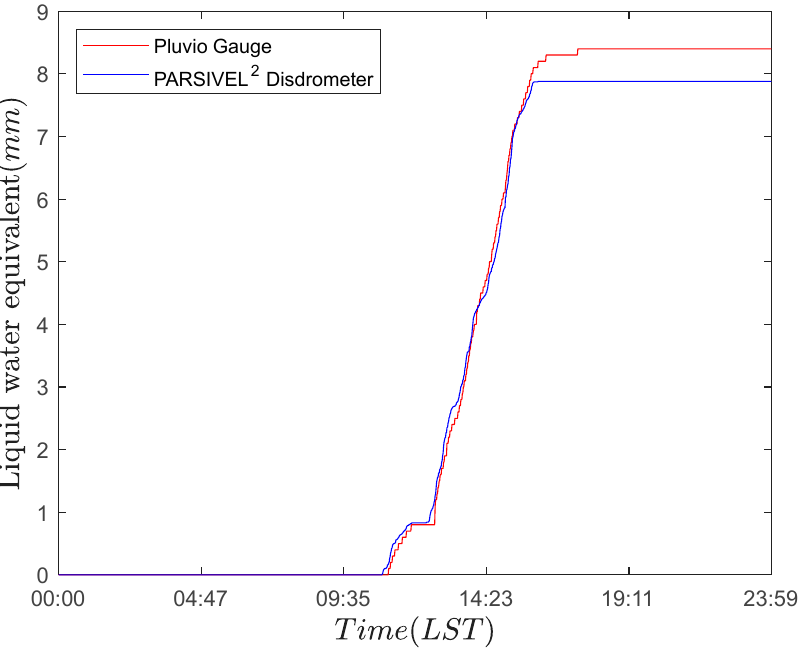
Figure 7. Comparison of snow cumulation from weighing precipitation gauge and disdrometer on 18 March 2022.